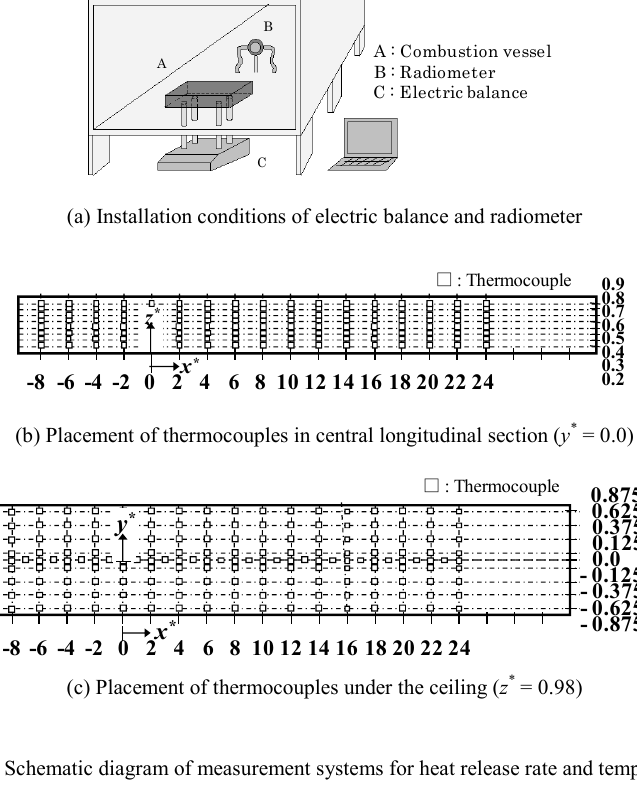
Fig. 2 Schematic diagram of measurement systems for heat release rate and